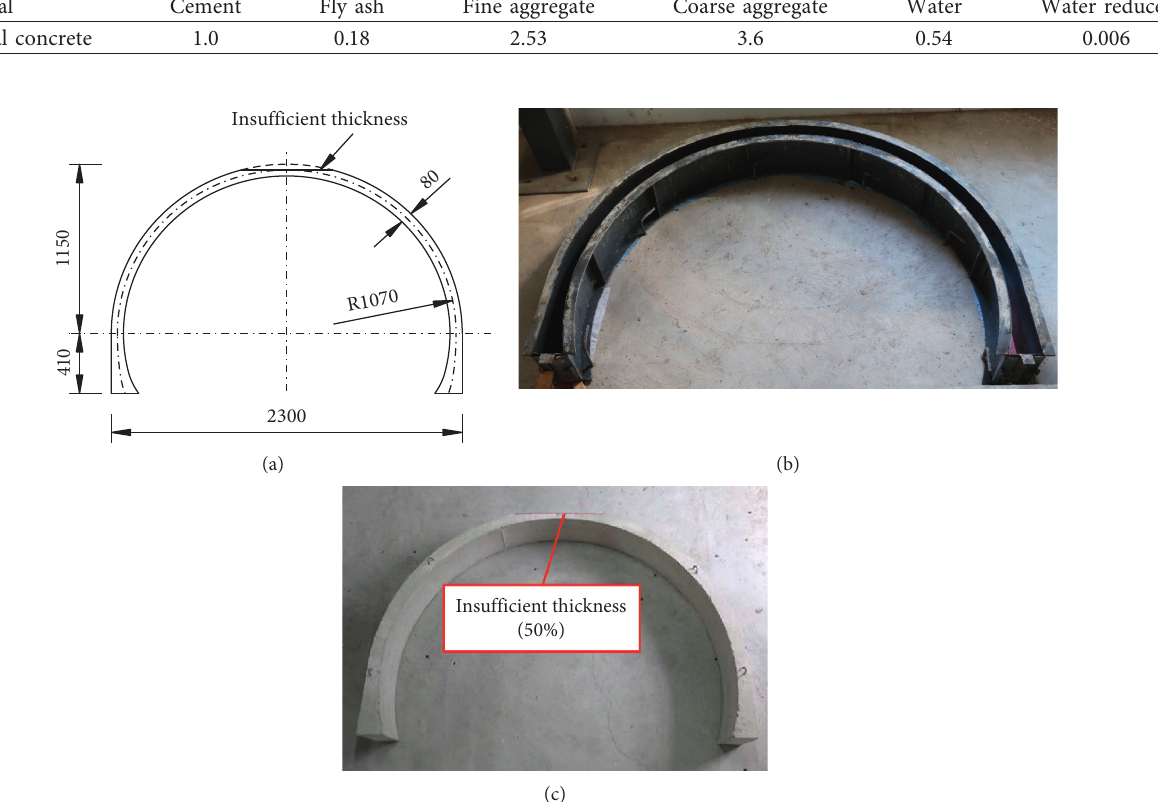
Figure 2: Lining specimen (unit: mm): (a) specimen geometry, (b) steel mold, and (c) lining specimen with thinning at the crown.